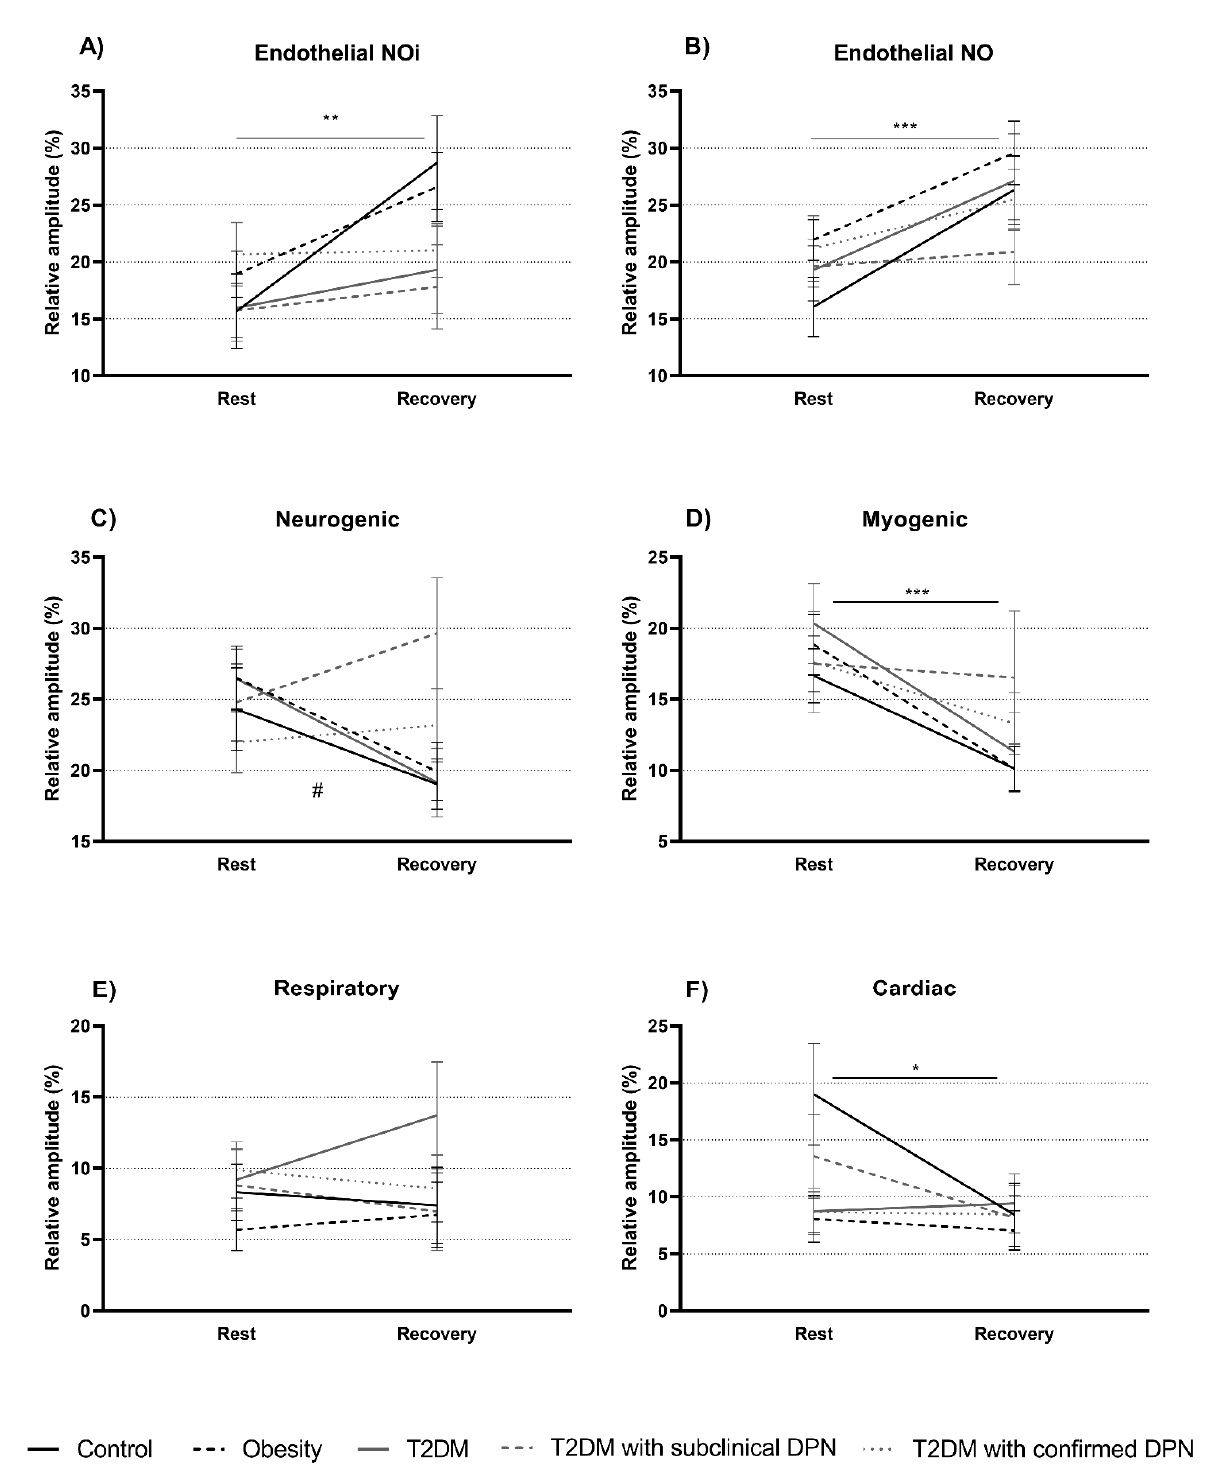
Figure 3. The relative contribution of each component at rest and during the leg dependency period at the medial malleus: endothelial NO-independent ( A ), endothelial NO-dependent ( B ), neurogenic ( C ), myogenic ( D ), respiratory ( E ), and cardiac ( F ) band. *** Time effect p < 0.001; ** Time effect p < 0.01; * Time effect p < 0.05; # Interaction Time × Group p = 0.07. DPN denotes diabetic peripheral neuropathy; T2DM, type 2 diabetes mellitus.